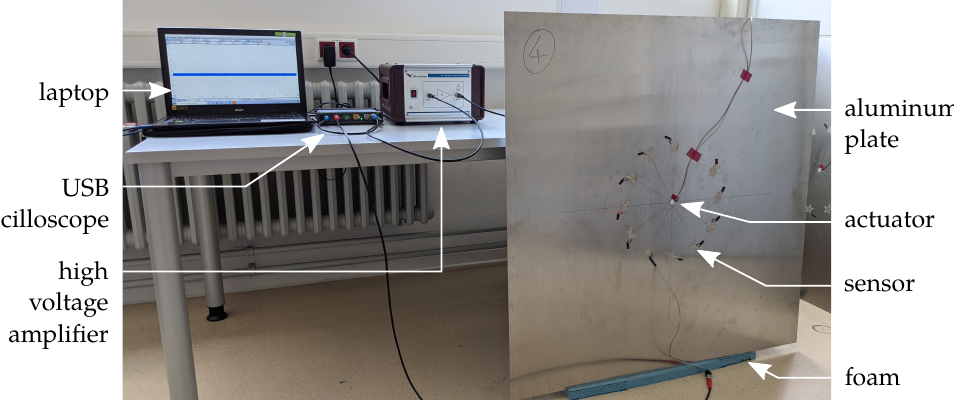
Figure 3. Test setup to determine the peak-to-peak voltage of the sensors under GUW excitation. For excitation, a 5-cycle, Hanning-windowed sine burst is used. The investigated burst center frequencies range from 5 kHz to 200 kHz with an interval of 5 kHz and from 200 kHz